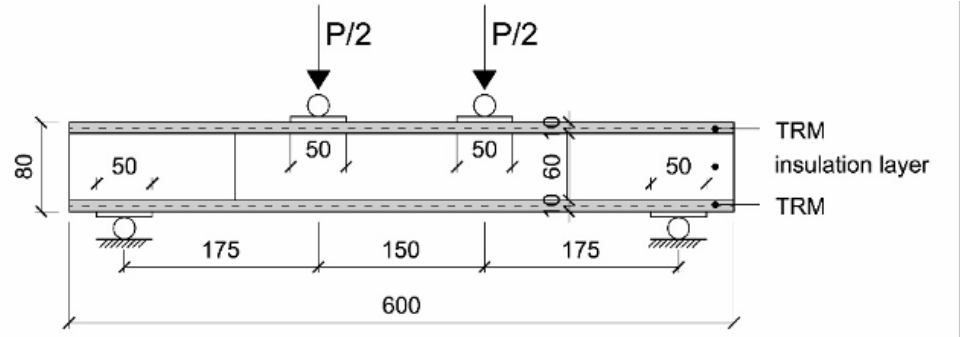
Figure 2. Four-point bending test set-up (Smart P.I.QU.E.R.).